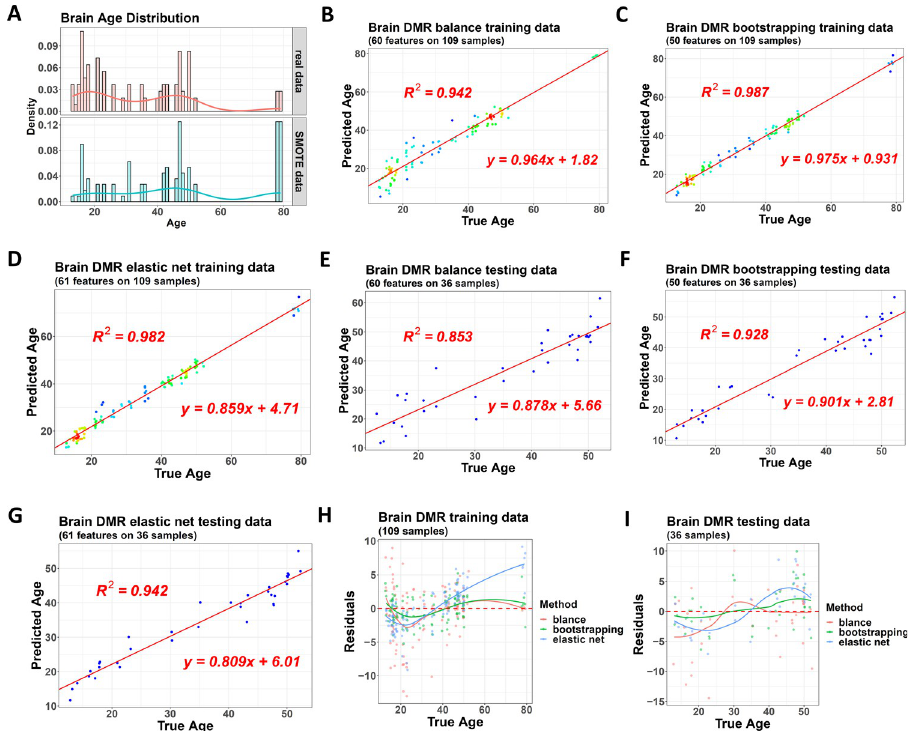
Fig 6. Performance of the three clock models on the 450K brain dataset. (A) The lifespan age distribution of the original training dataset before (upper) and after (lower) the adjustment by the balanced clock model, with samples from all the 10 base learners combined and shown, including synthesized samples from SMOTE and repeated samples due to bootstrapping and bagging. (B) to (D) Performance of the balanced model (B), bootstrapped model (C), and single normal model (D) on the same training dataset with DMRs as features. The color gradients of the dots indicate the density of the samples. (E) to (G) Performance of these three models on the same testing dataset with DMRs as features. (H) and (I) Residuals of the three models in training and testing